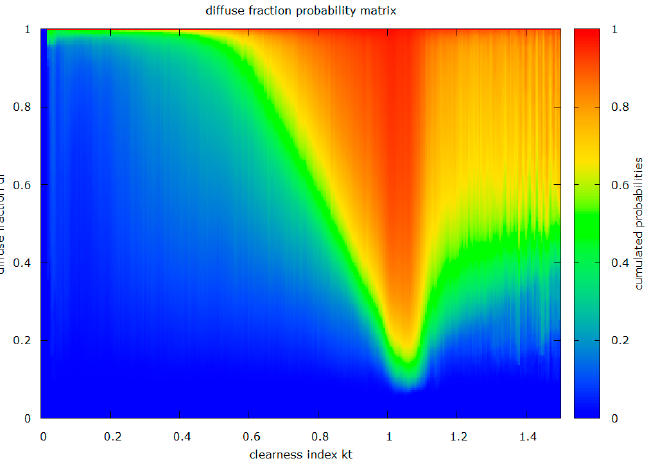
Figure 4. A probability matrix of the diffuse fraction as a function of the clearness index kt . For each value of kt , this matrix describes the probability with which a certain value of diffuse fraction will occur. The matrix correlates with the existing simple one-parameter models mentioned in Section